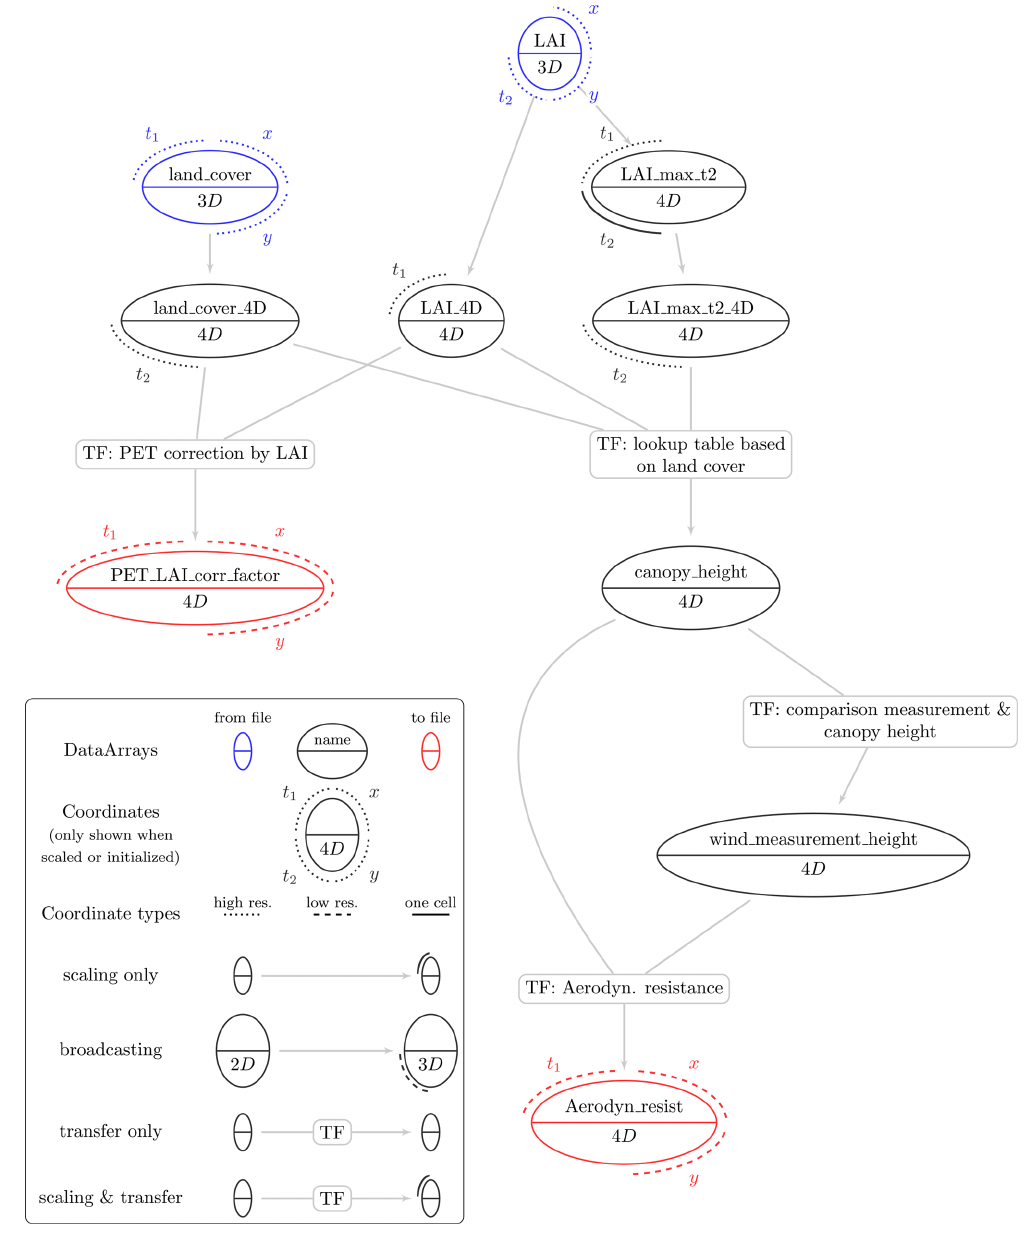
Figure 3. Dependency graph of two of the mHM parameters in their standard